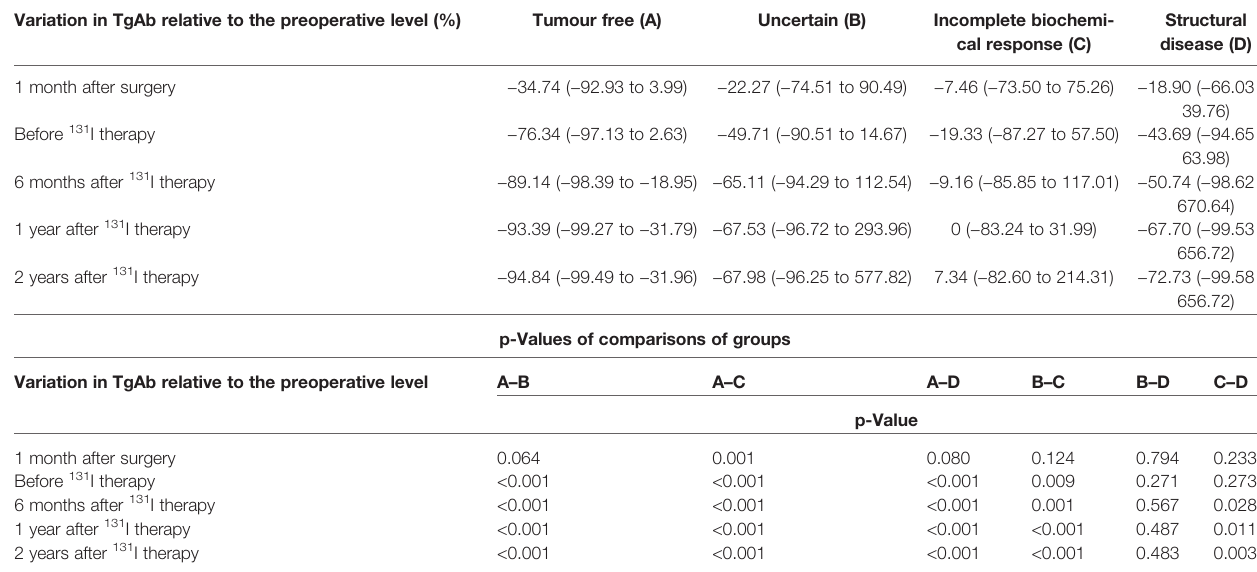
TABLE 3 | Comparison of the variations in TgAb relative to the preoperative levels.